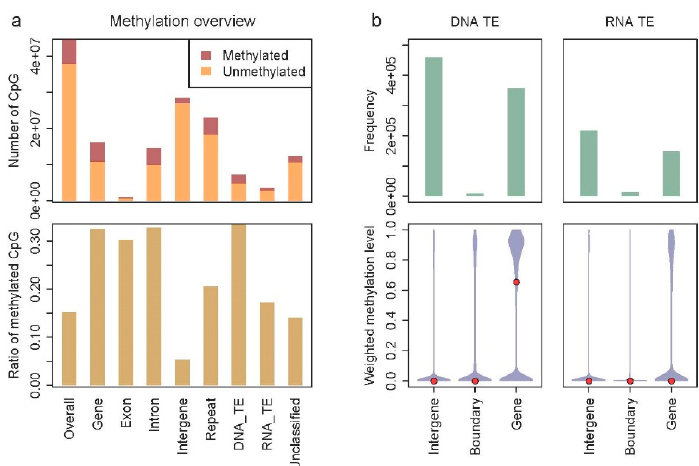
Figure 1. Distribution of CpG DNA methylation across the genome of Stegodyphus dumicola . ( a ) The upper part shows the numbers of CpGs and the lower part shows the relative DNA methylation of CpGs in different genomic elements. The genomic elements are nested: “Overall” covers the entire genome, “Gene” covers exons and introns, while “Repeat” covers DNA TEs (DNA_TE), RNA TEs (RNA_TE), and unclassified repeats. ( b ) DNA methylation of CpGs located in DNA and RNA TEs. The upper part shows the number of TEs located in “Intergenic regions,” in “Intergenic-genic boundaries,” and in “Genes.” The lower part shows the distribution of the methylation level in the three different categories. The medians are shown with red dots.